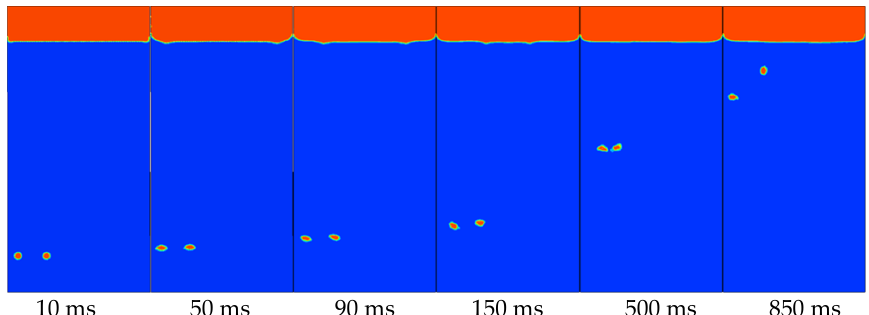
Figure 20. The shape change of the rising double bubbles arranged horizontally near the wall.